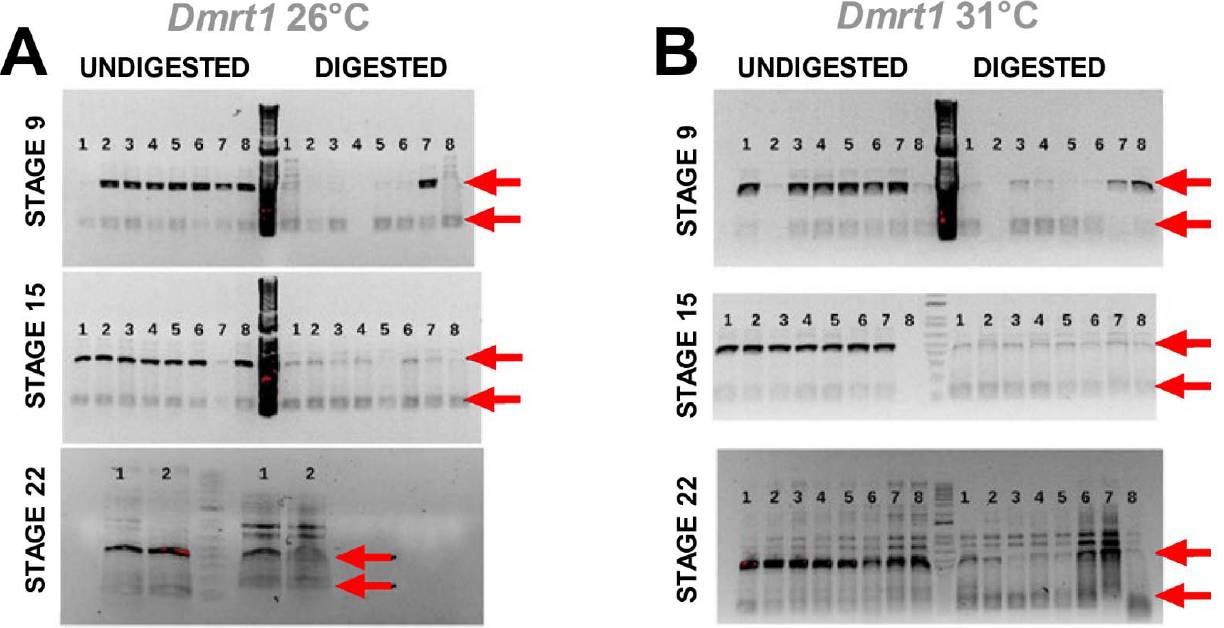
Figure 3. Agarose gels of DNA methylation-sensitive PCR assay for Dmrt1 at MPT ( A ) and FPT ( B ). Invitrogen’s 1 kb Plus DNA ladder was used. Arrows show the size of the two amplicons expected (120 bp and 438 bp) when DNA is methylated and thus protected from digestion by the restriction enzyme, as detailed in the text.